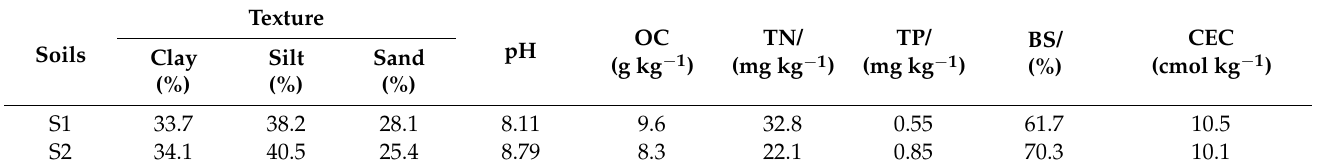
Table 3. The physicochemical properties for S1 and S2 soils in addition to the soil salt